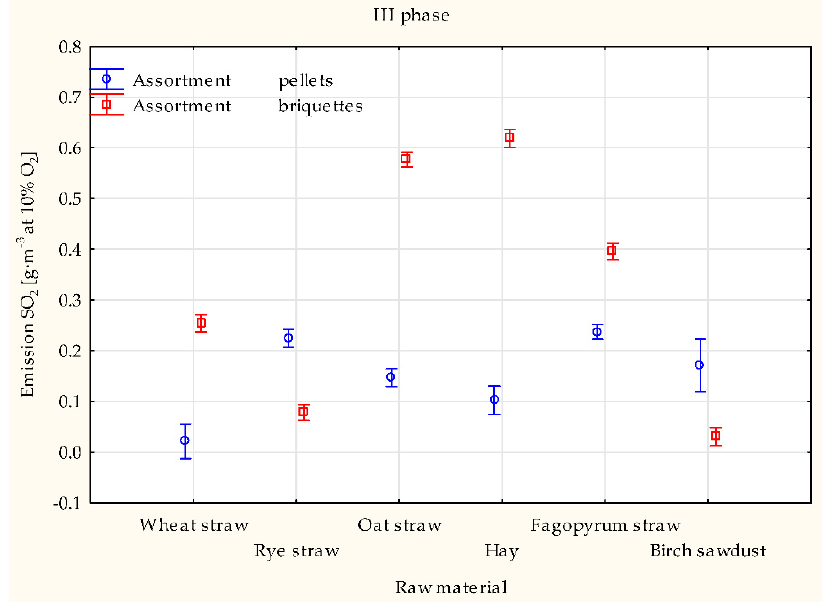
Figure 3. Emission SO 2 in I, II and III phase combustion.